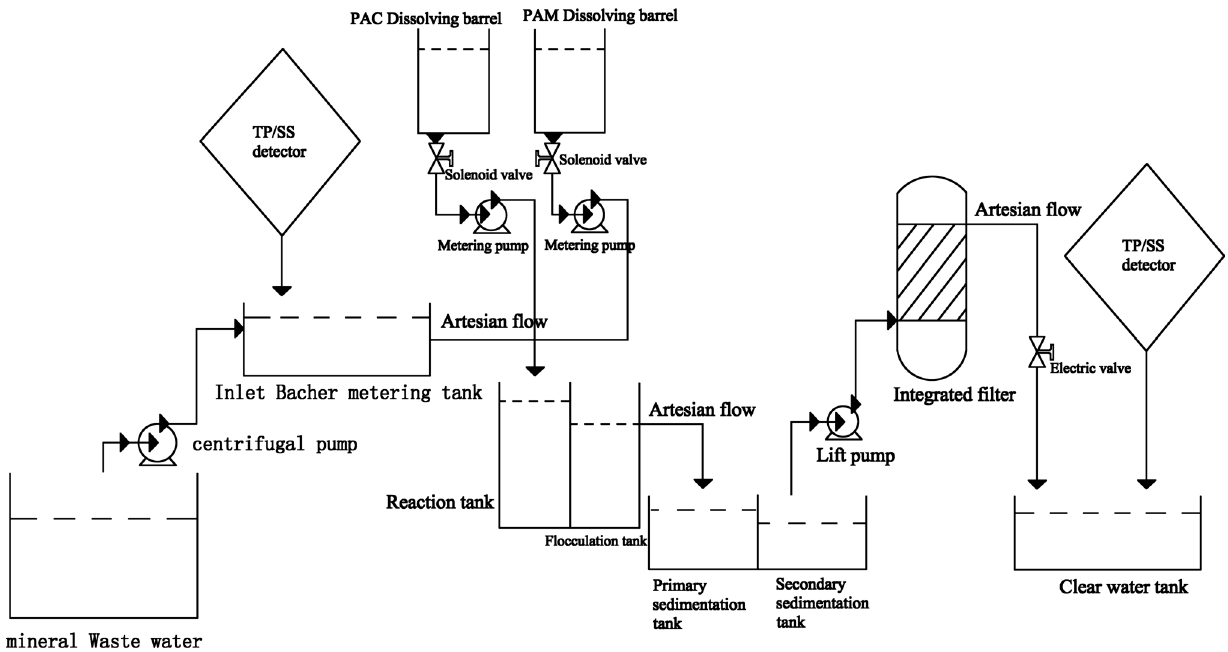
Fig. 1 Composition of phosphate sewage treatment control